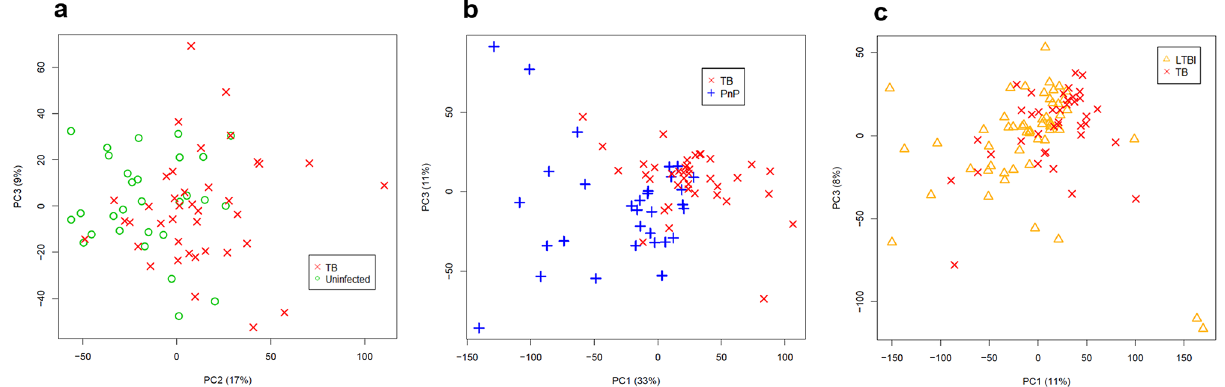
Figure 4. Principal Component Analysis (PCA) score plots of urine spectra analyzed by low-field Nuclear Magnetic Resonance between 39 untreated TB (x) and: ( a ) 29 uninfected individuals (circle), ( b ) 31 pneumococcal pneumonia patients (cross), and ( c ) 53 LTBI individuals (triangle). TB, tuberculosis; PnP, pneumococcal pneumonia; LTBI: latent TB infection; PC, Principal